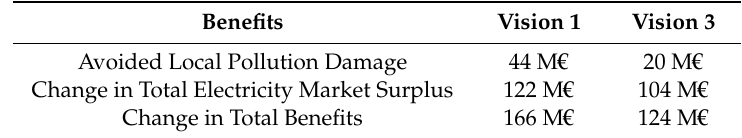
Table 4. Change in system-wide benefits of the project (EMS, LPD, and TB) for Vision 1 and Vision 3 in 2030.